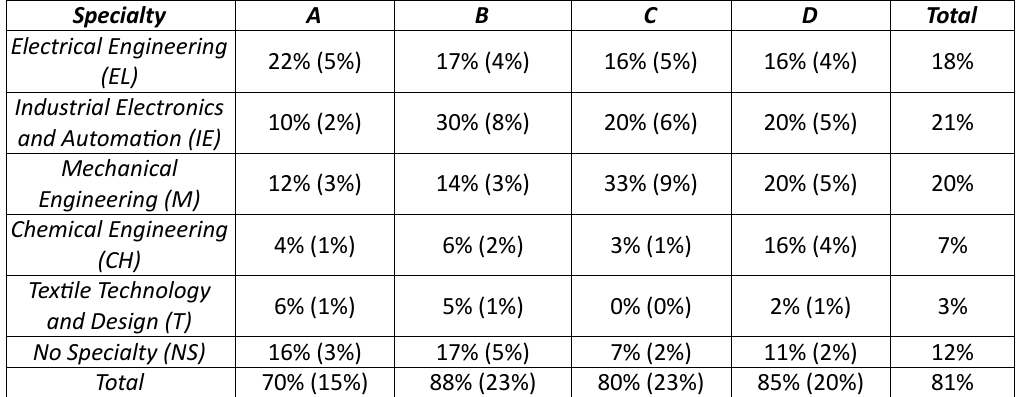
Table 8. Academic year 2012/13 - Percentages of average passing grades (>=5/10 and <8/10), by group and specialty (the percentage of the total is indicated in